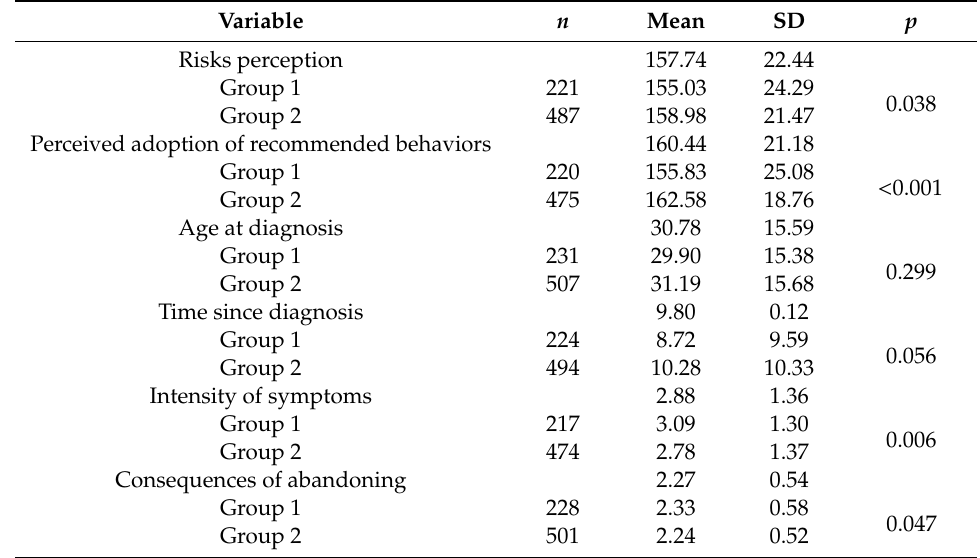
Table 5. Scores for risk perception (CDRAQ), perceived adoption of recommended behaviors (CDRBQ), age at diagnosis, time since diagnosis, intensity of symptoms, and consequences of abandoning.